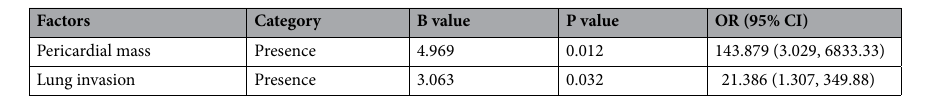
Table 5. Independent predictors by Cox regression analysis for high-risk